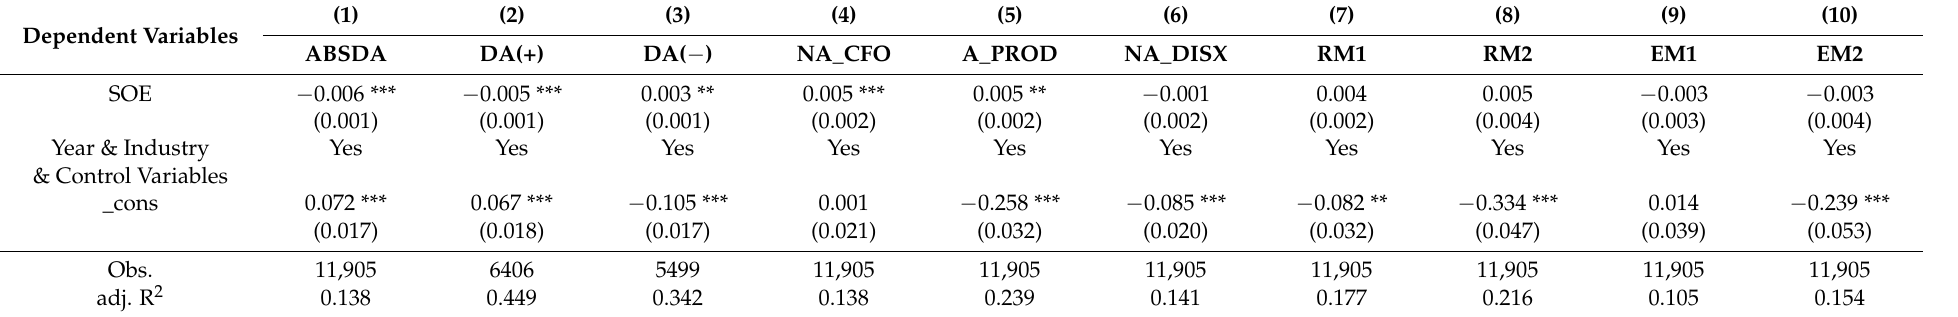
Table 7. The Effect of State Ownership on Real Earnings Management and Accruals